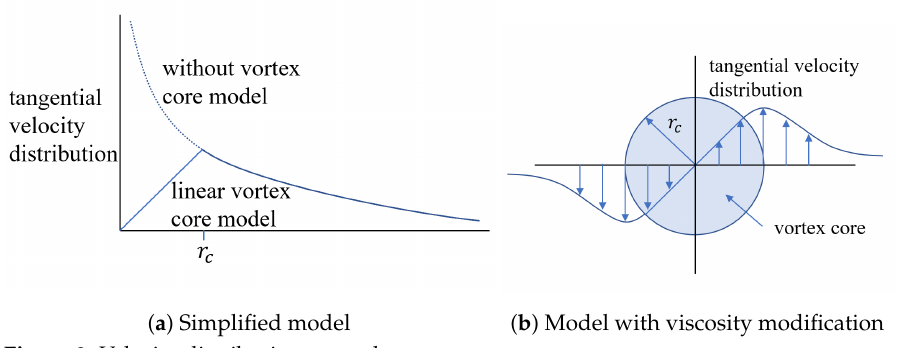
Figure 3. Velocity distribution around a vortex